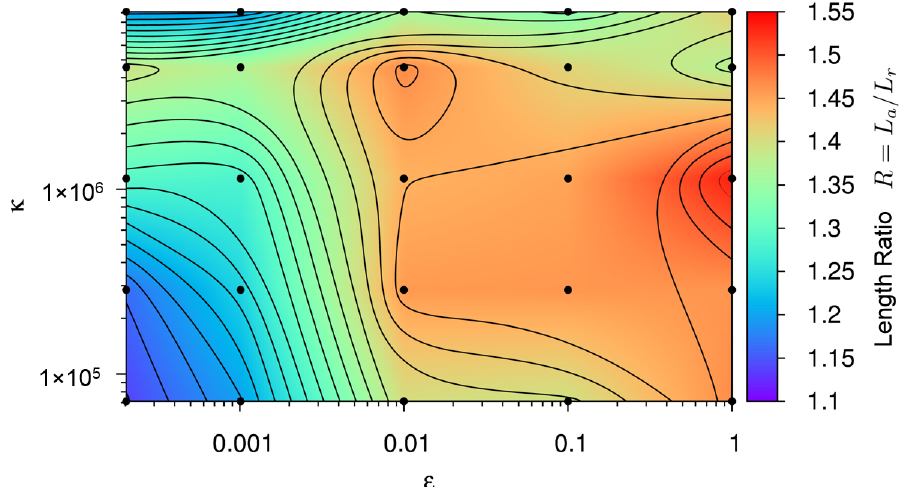
Figure 9. Contour plot representing the debris cloud’s axial to radial extension ratio, R = L a / L r , for each simulation in Figure 7. Color code refers to the length ratio R shown on the right side of the figure. See main text for